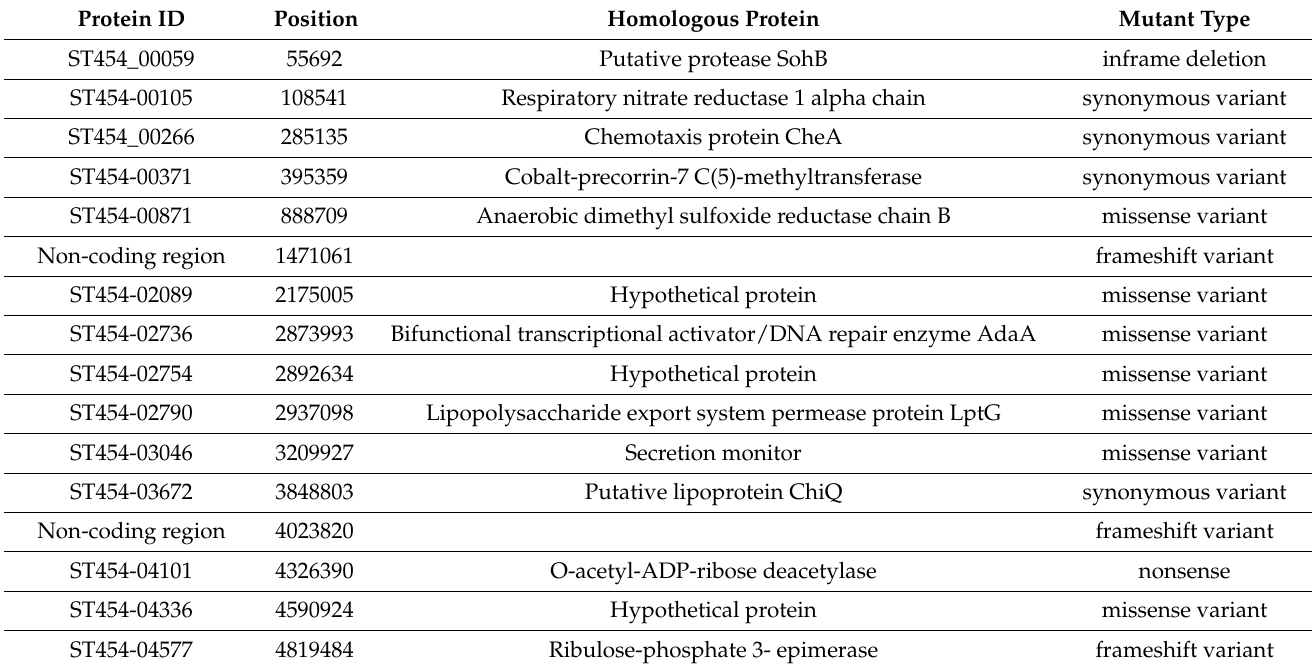
Table 4. Mutated genes in